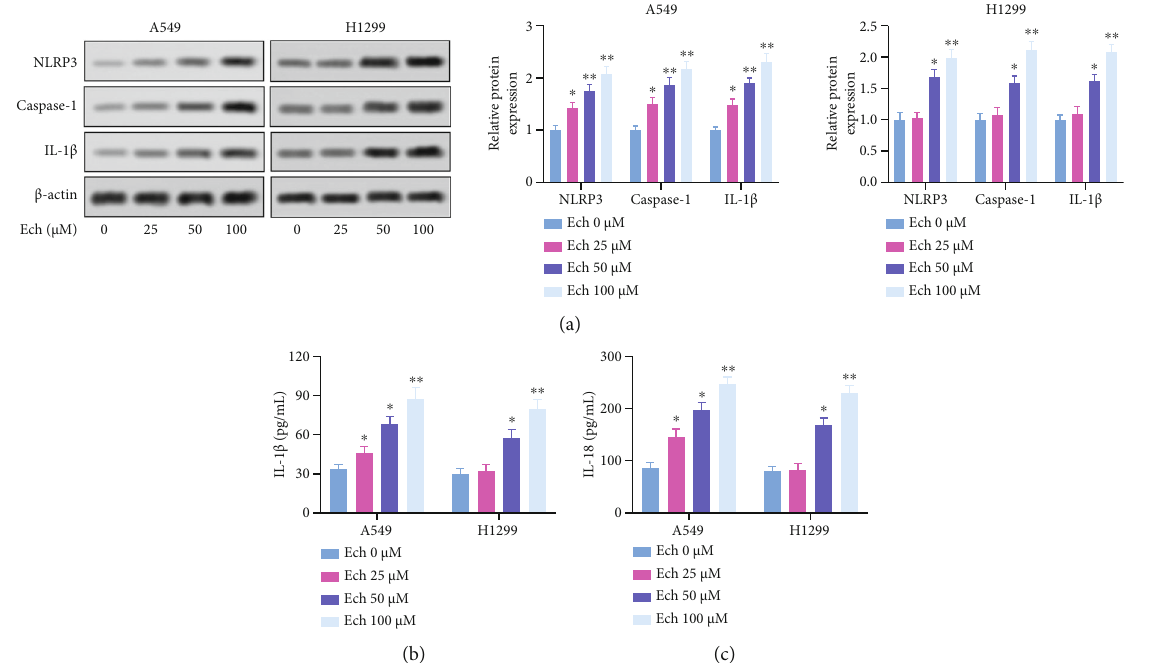
Figure 2: Ech induced pyroptosis in NSCLC cells. (a) Representative western blot showing protein levels of NLRP3, caspase-1, and IL-1 β . (b) Supernatants were analyzed for IL-1 β by ELISA. (c) The contents of IL-18 were detected by ELISA. Data were represented as mean ± SD . ∗ P < 0 : 05 and ∗∗ P < 0 : 01